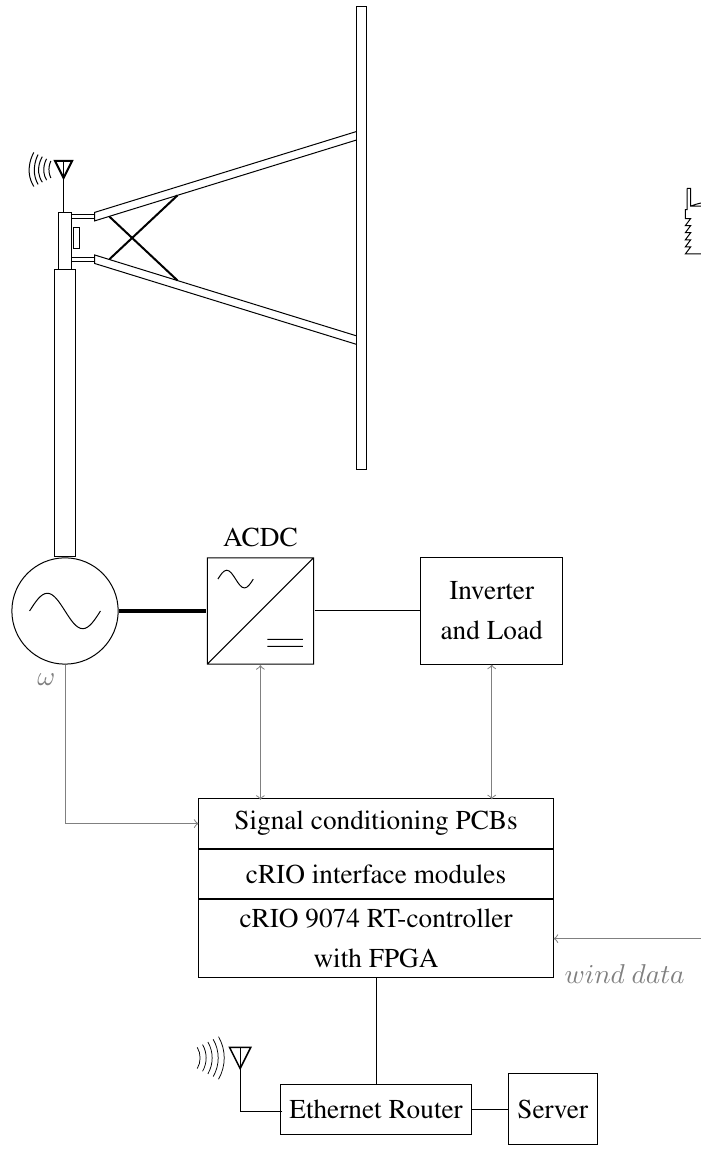
Figure 5. Overview of the control and measurement